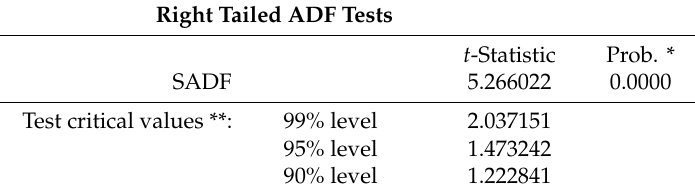
Table 2. Supremum Augmented Dickey–Fuller (SADF) results for WTI Crude Oil price.